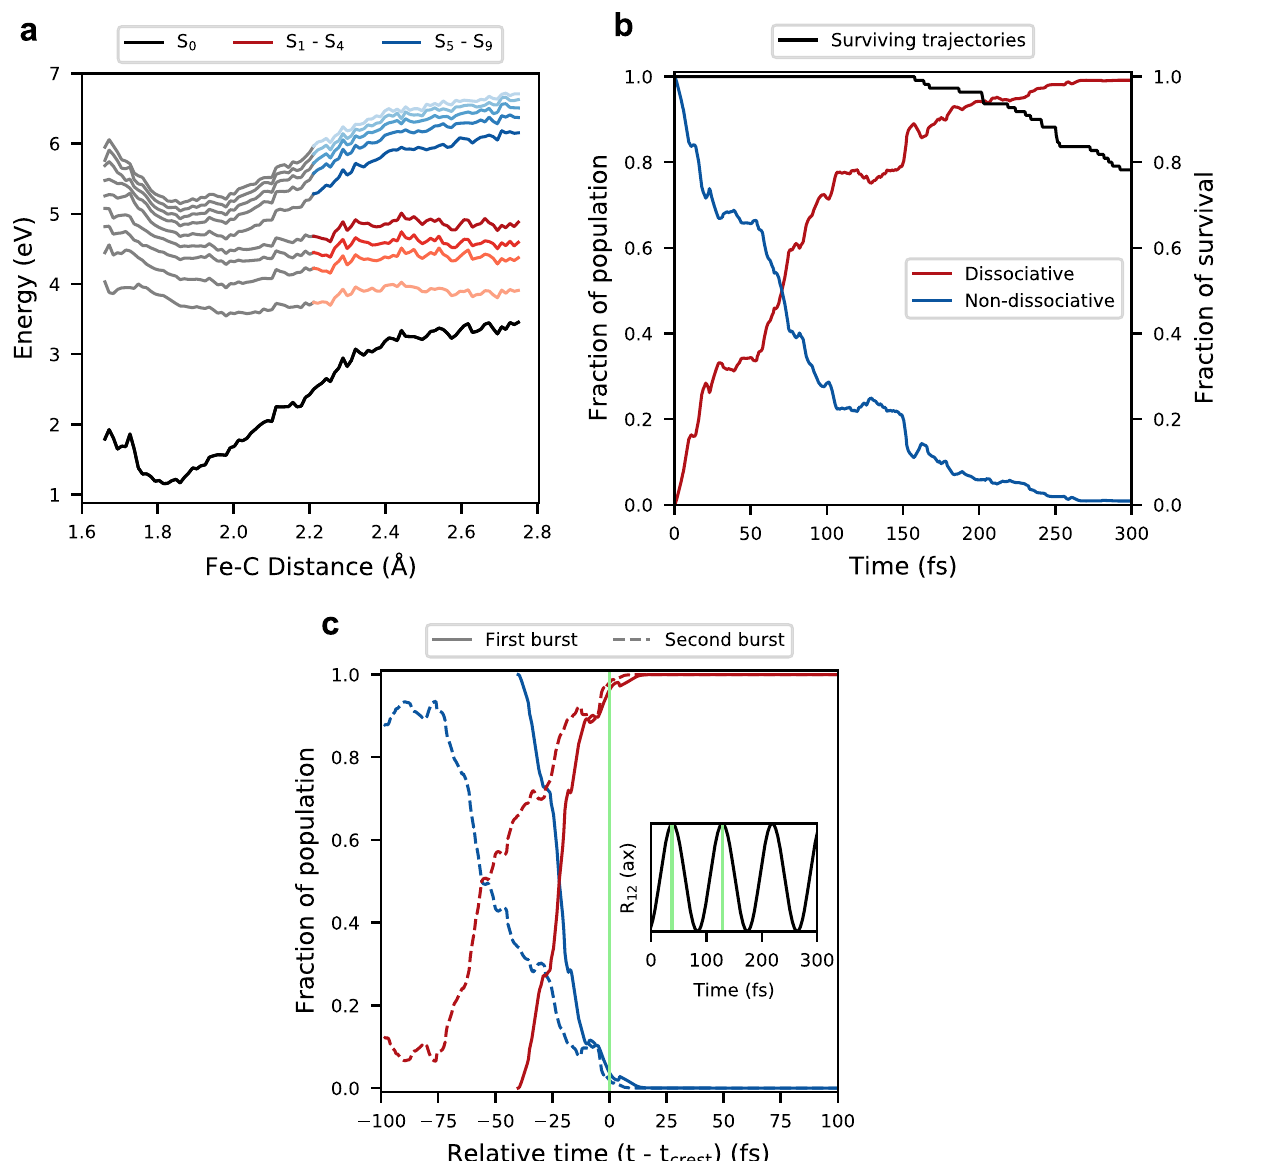
Fig. 4 Electronic population dynamics for the photodissociation of Fe(CO) 5 . a The potential energy of all the states along the excited state molecular dynamics (ESMD) simulations were sampled as a function of Fe – C distance, corresponding to the released CO, and averaged over the 110 singly dissociative trajectories. At long Fe – C distance, non-dissociative metal-to-ligand charge-transfer (MLCT) and dissociative metal-centered (MC) states are colored blue and red, respectively. b Population dynamics of non-dissociative, ie. S i ( i = 5 − 9), and dissociative, ie. S j ( i = 1 – 4), states averaged over the 110 single dissociation trajectories. The black line represents the fraction of trajectories that survives as a function of time. c Normalized population dynamics for the two prominent bursts in subset of trajectories with axial dissociation from Fig. 2 presented on a relative time axis. The relative time 0 fs for fi rst and second burst matches the corresponding crests of the oscillation of R 12 (ax), respectively. The inset shows the schematic R 12 (ax) oscillation and the green lines indicate the positions of t crest for fi rst and second burst of axial CO